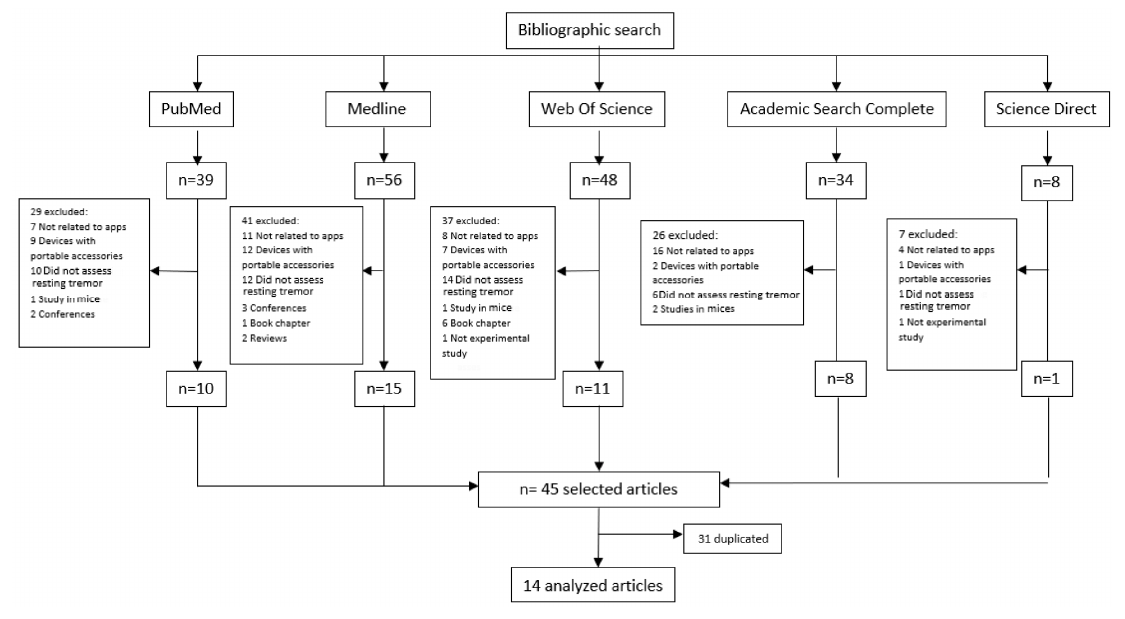
Figure 1. Flowchart of the bibliographic